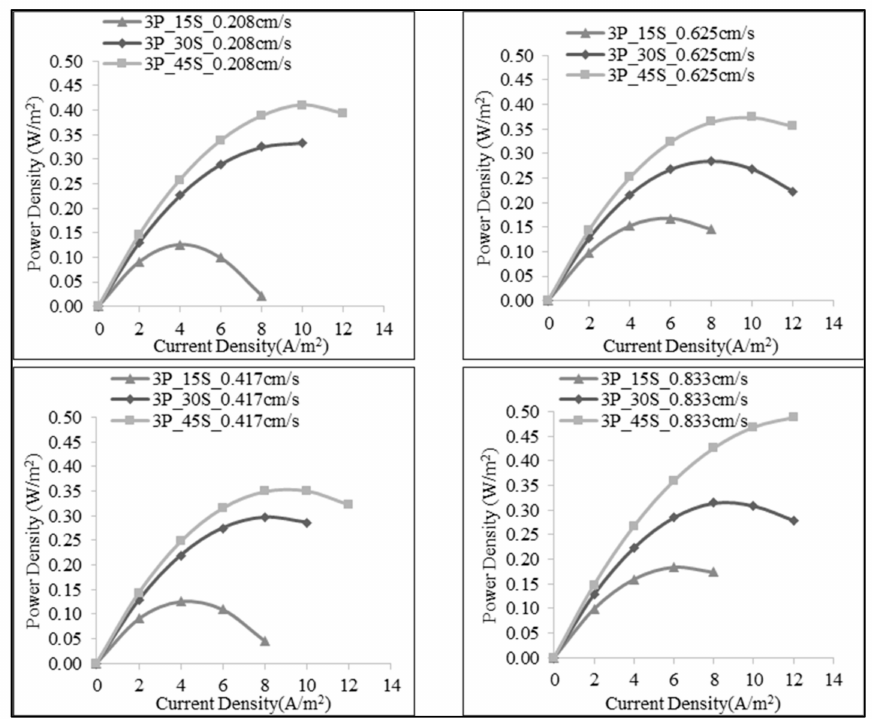
Figure 7. The effect of the salt ratio of feed solutions on power density for 3 membrane pairs. (XP_YS_Zcm/s indicates X membrane pair, Y salt content of HSS and Z feed